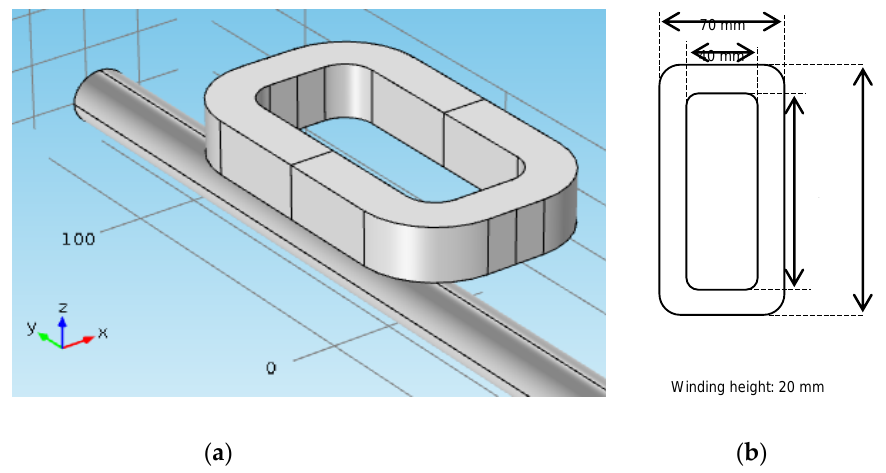
Figure 4. The electromagnetic components of an ECT sensor to inspect the reinforcement of concrete structures. ( a ) Perspective view; ( b ) Coil dimensions.